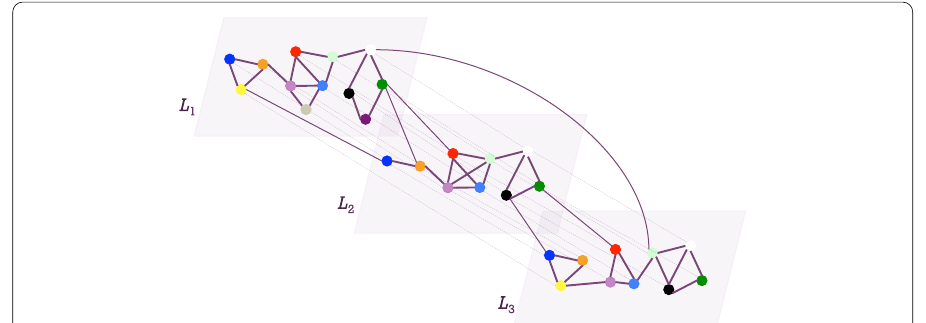
Fig. 1 Example multilayer network handled by our framework, with color codes mapping nodes of the same entity: in addition to within-layer edges (solid thick lines), note the presence of both inter-layer pillar edges (dashed thin lines) and inter-layer edges connecting nodes of different entities (solid thin